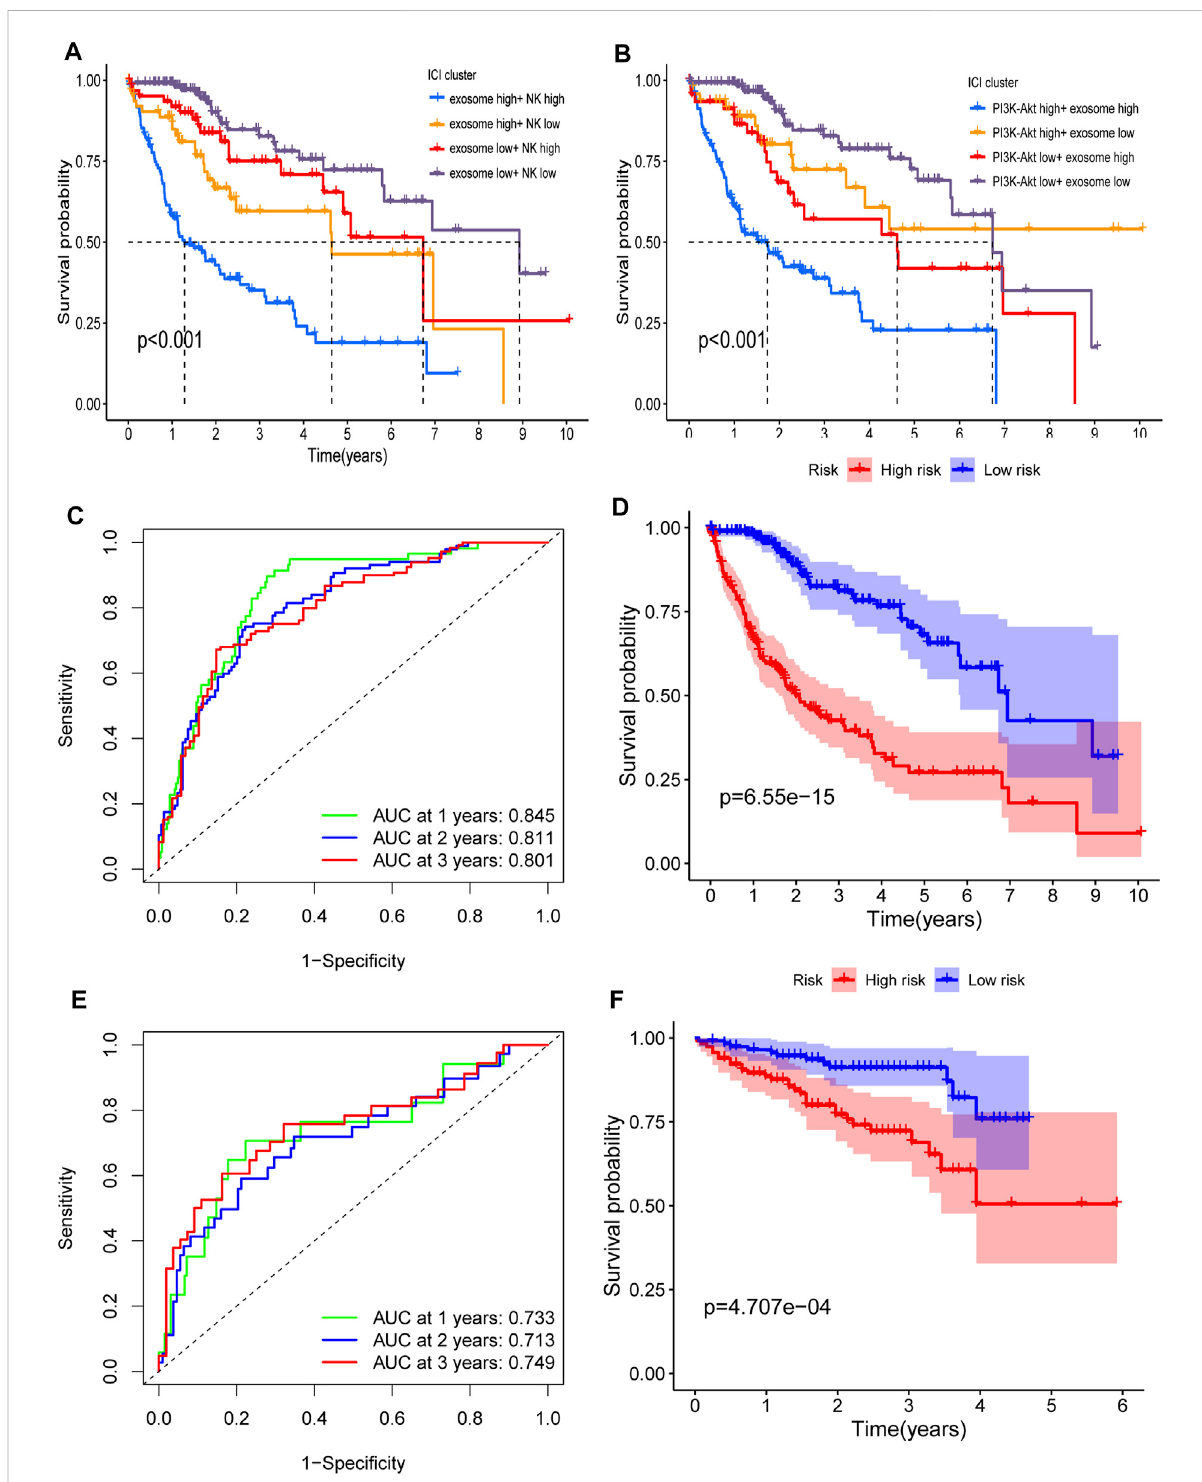
FIGURE 6 Interactionandveri fi cationoftheRFsignature. (A) InteractionoftheexosomescoreandNKscore.Kaplan – MeiercurvesfortheOSofpatientsin exosome scorehigh+NKscore high,exosome scorehigh+NKscore low,exosomescore low+NKscorehigh, andexosome scorelow+NKscore low in TCGA cohort ( p < 0.001). (B) Interaction of the PI3K-Akt score and exosome score. Kaplan – Meier curves for the OS of patients in PI3K-Akt score high + exosome score high, PI3K-Akt score high + exosome score low, PI3K-Akt score low + exosome score high, and PI3K-Akt score low+exosomescorelowinTCGAcohort( p < 0.001). (C,D) AUCoftime-dependentROCcurves (C) andKaplan – Meiercurves (D) oftheRFsignature in TCGA. (E,F) AUC of time-dependent ROC curves (E) and Kaplan – Meier curves (F) of the RF signature in